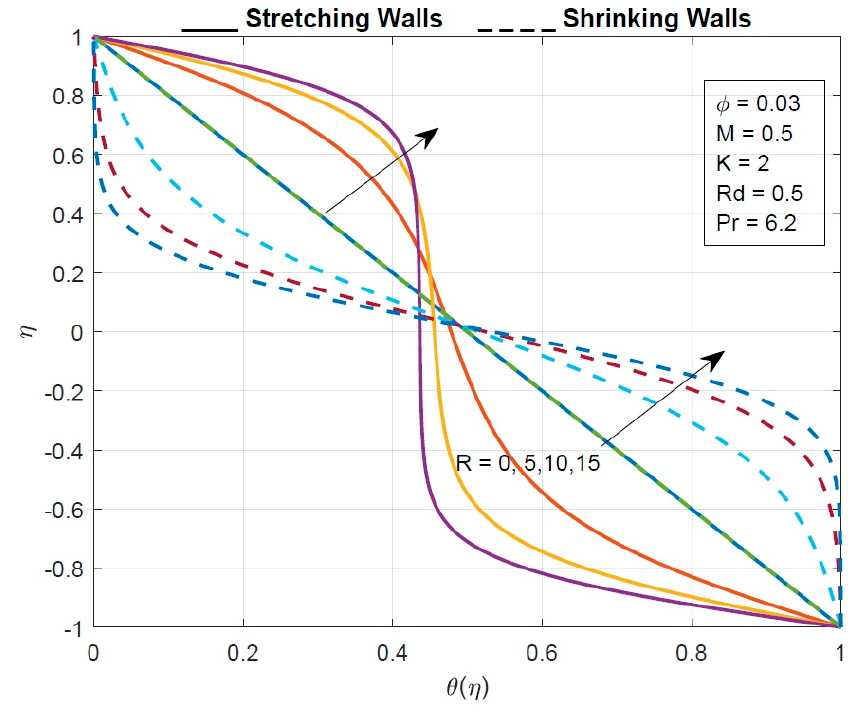
Figure 11. T he effect of the Reynolds number on the temperature profile.